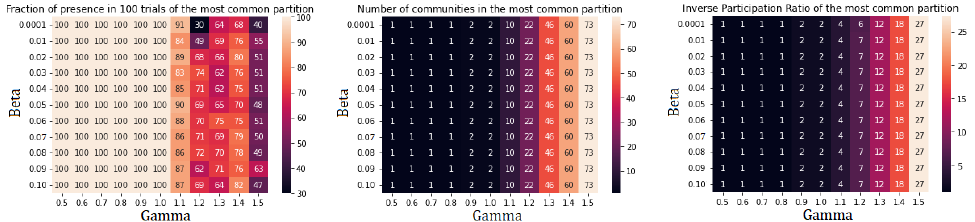
Figure A6. Performance indicators for Leiden algorithm applied to the whole StartupBlink network. Two communities are found: community 0 (49 nodes) and community III (51 nodes).